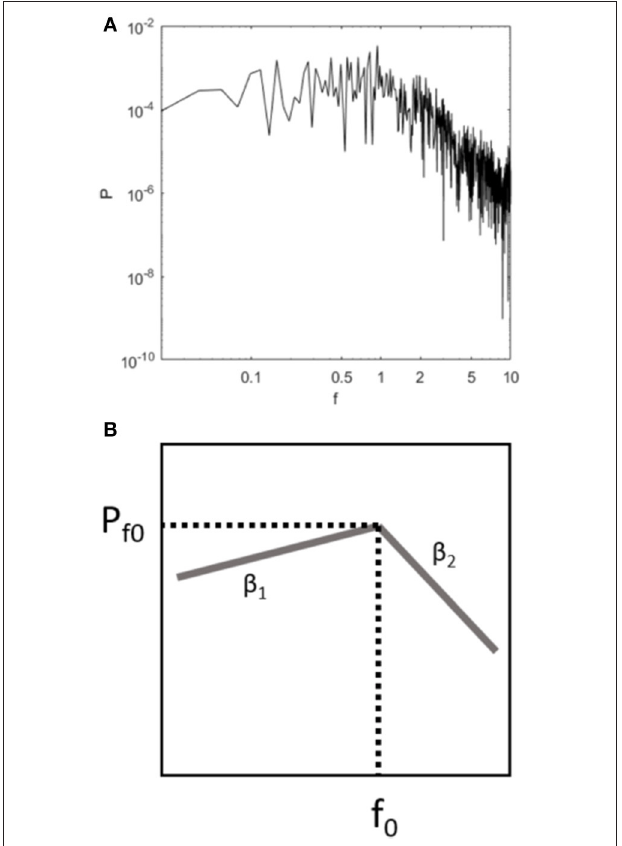
FIGURE 7 | Typical PSD of COP velocity on the AP axis (A) , and its schematic representation (B) revealing four key parameters: P f0 , β 1 , β 2 , f 0 .